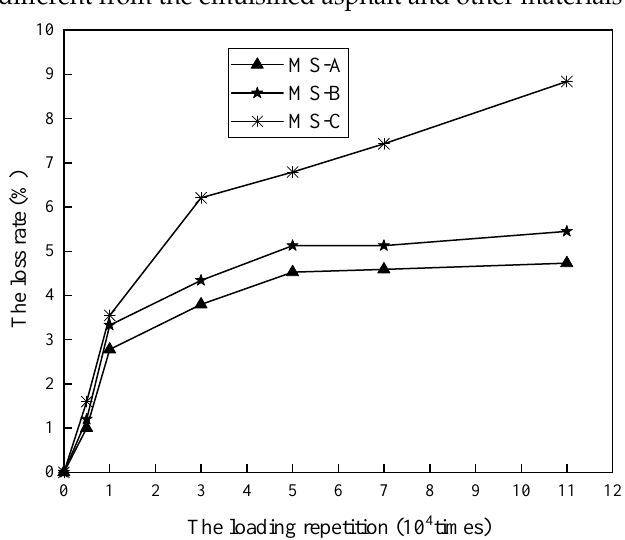
Figure 8. The relationship between mass loss rate and loading